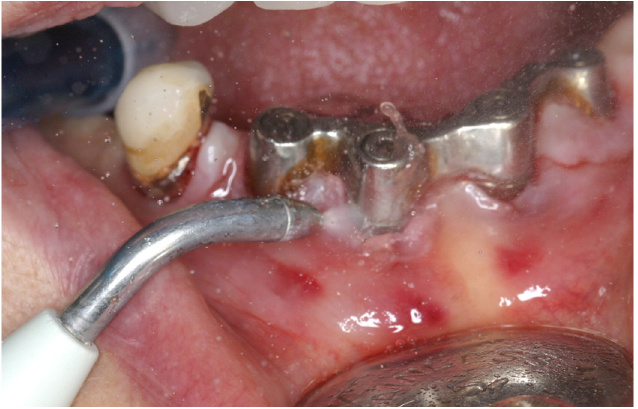
Figure 3 . OHLLT surgical approach. Air flow device with sodium bicarbonate powder (high abrasive powder).